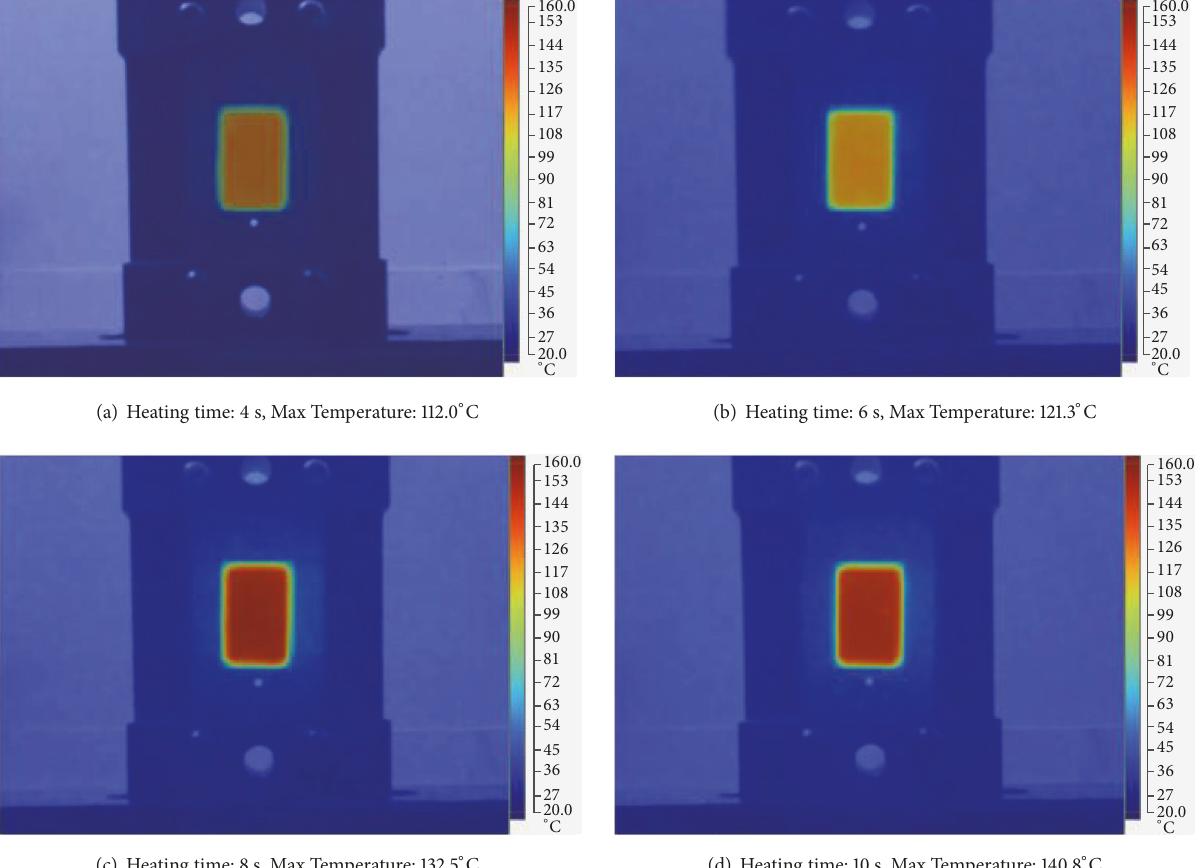
Figure 20: Temperature distribution at the end of the heating step for the thin rib cavity at different heating times.